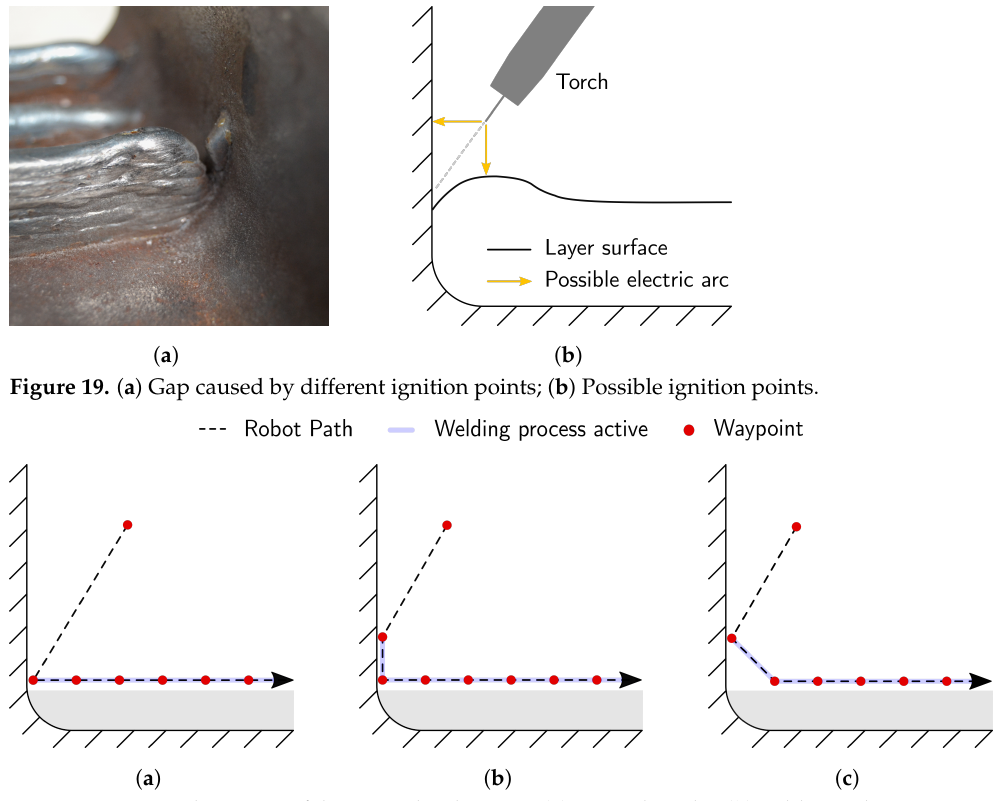
Figure 20. Development of layer path planning ( a ) primal path; ( b ) additional way point; ( c ) without